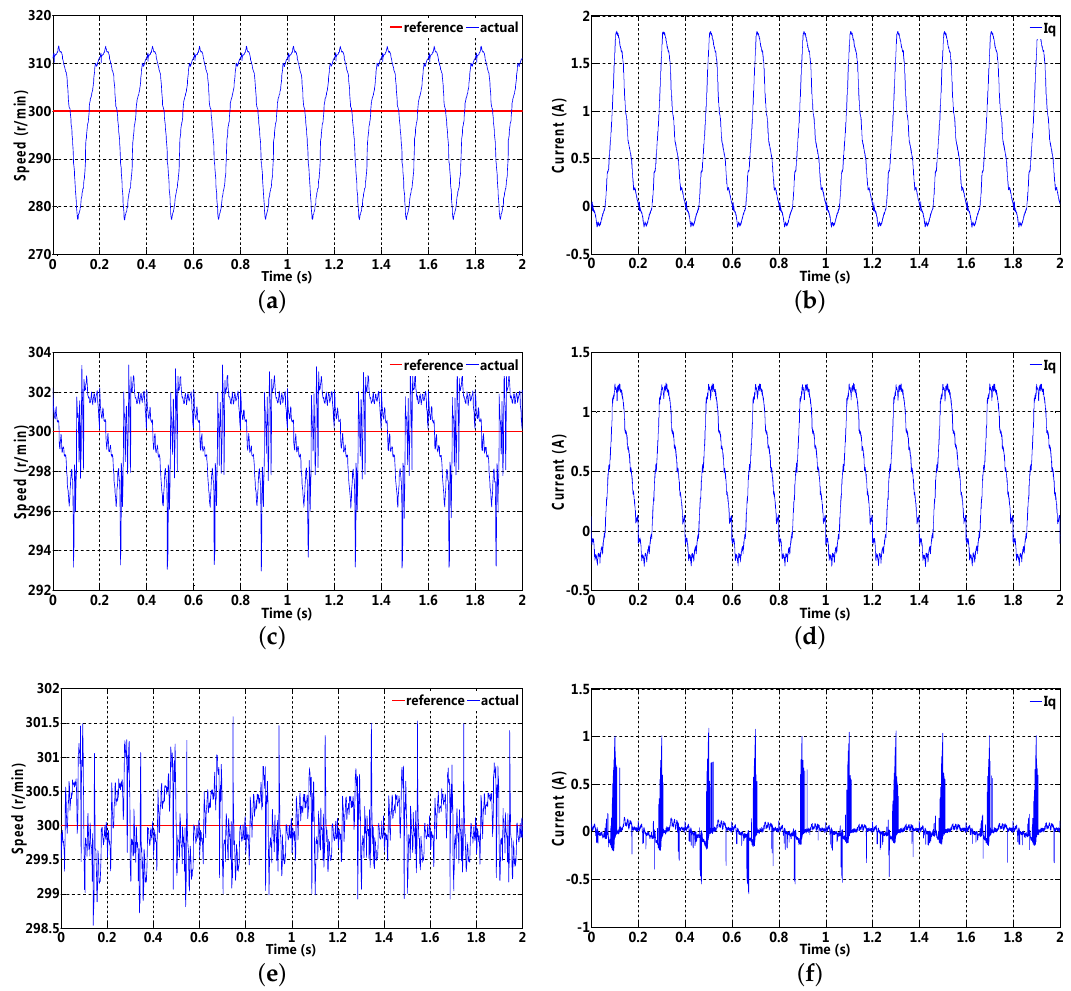
Figure 17. Speed and corresponding q -axis current based on the original PI controller (without disturbance compensation), DOB and APDOB (15 Hz): ( a , b ) speed and corresponding q -axis current with the original PI controller; ( c , d ) speed and corresponding q -axis current with DOB; ( e , f ) Speed and corresponding q -axis current with